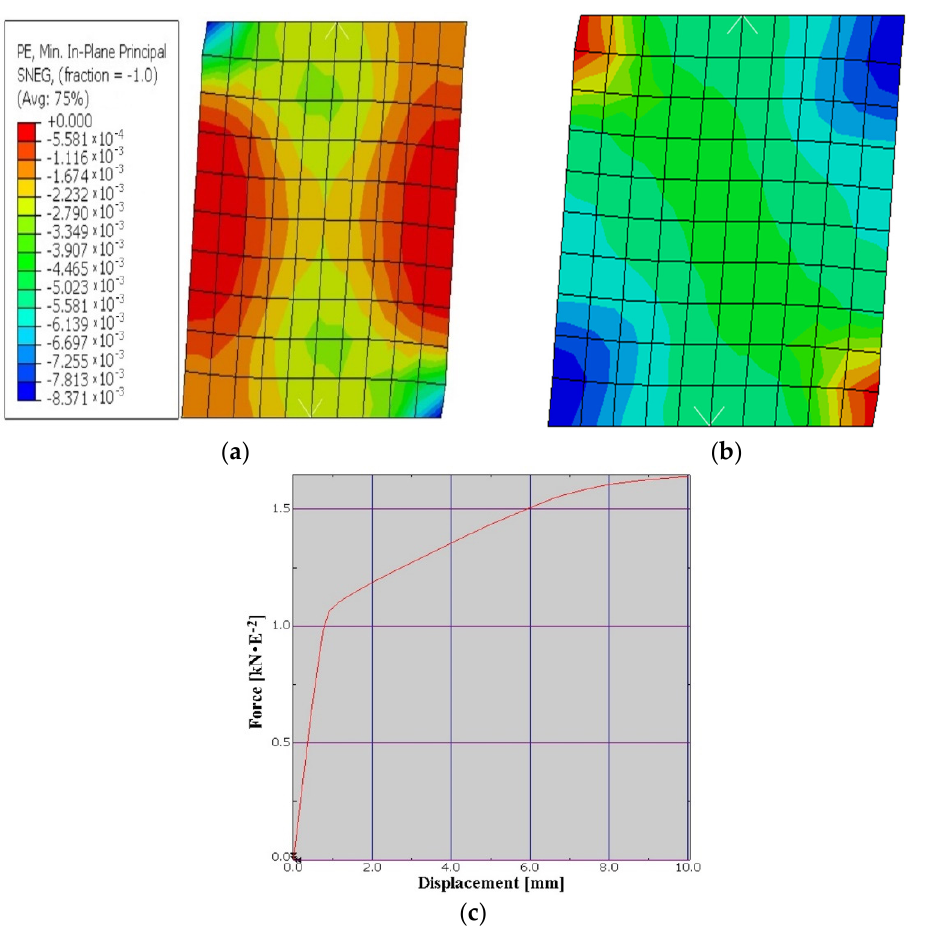
Figure 8. Compression plastic strain ( a ); strain components at integration point ( b ); graph of force– displacement to CBWC2 ( c ).